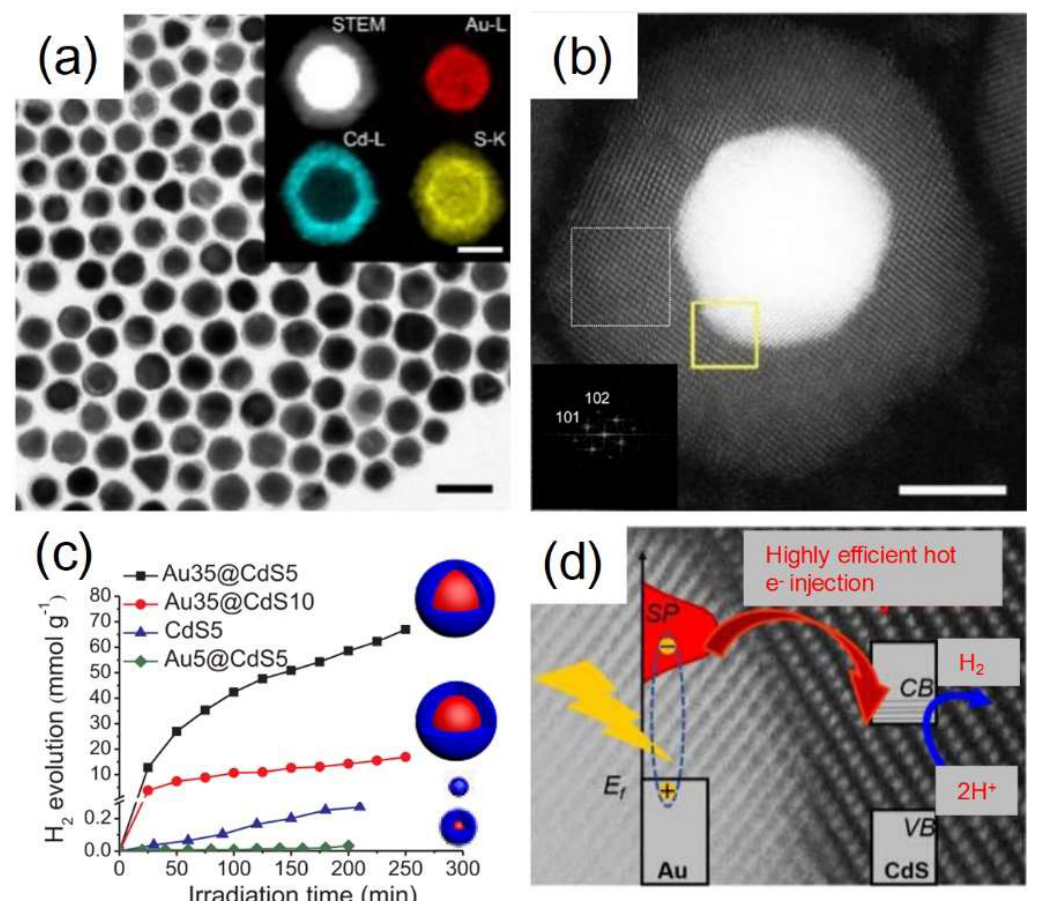
Figure 1. ( a , b ) Morphology characterization of prepared Au@CdS nanocrystals. Scale bar in ( a ) and ( b ) are 20 nm and 10 nm, respectively. ( c ) Photocatalytic hydrogen evolution of prepared Au@CdS with different architectural feature in comparison with pure CdS under visible light irradiation. ( d ) Possible physical mechanism of the hot electron-mediated photocatalysis. Copyright 2018